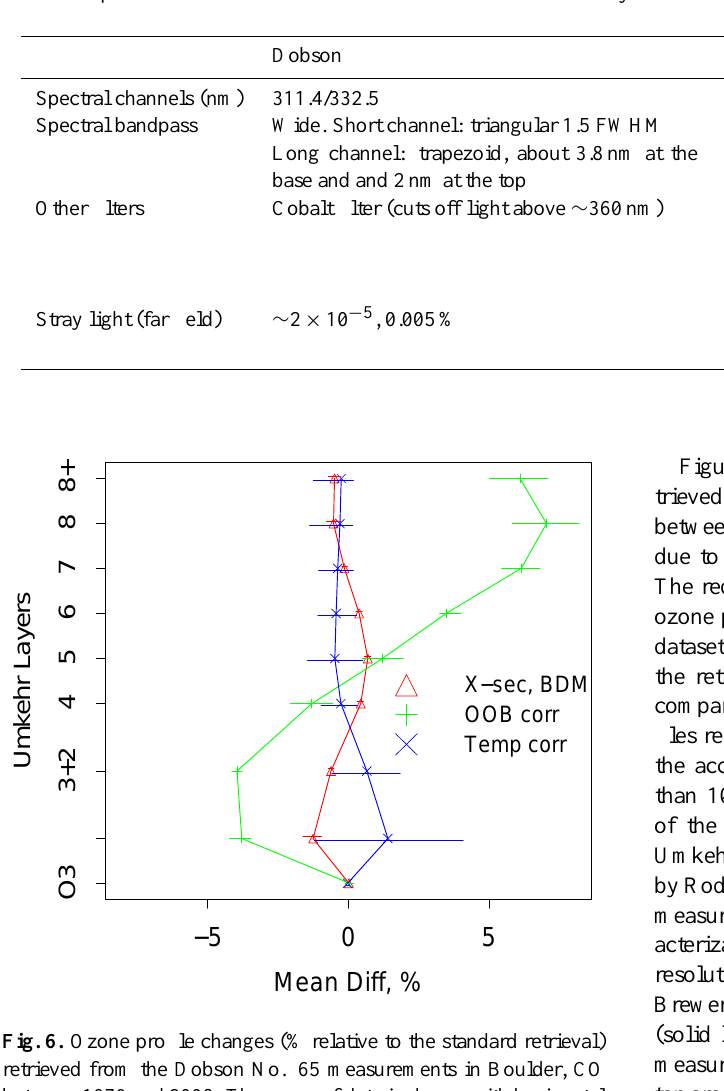
Table 1. Optical characteristics of the Dobson and Brewer Umkehr system.